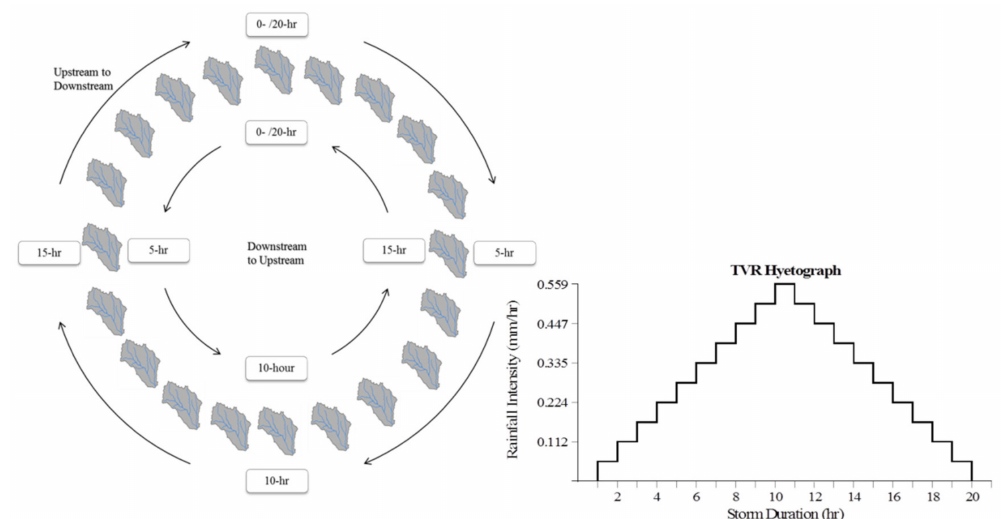
Figure 7. Temporally varied rainfall (TVR) applied to Cowleech Fork of the Sabine River,